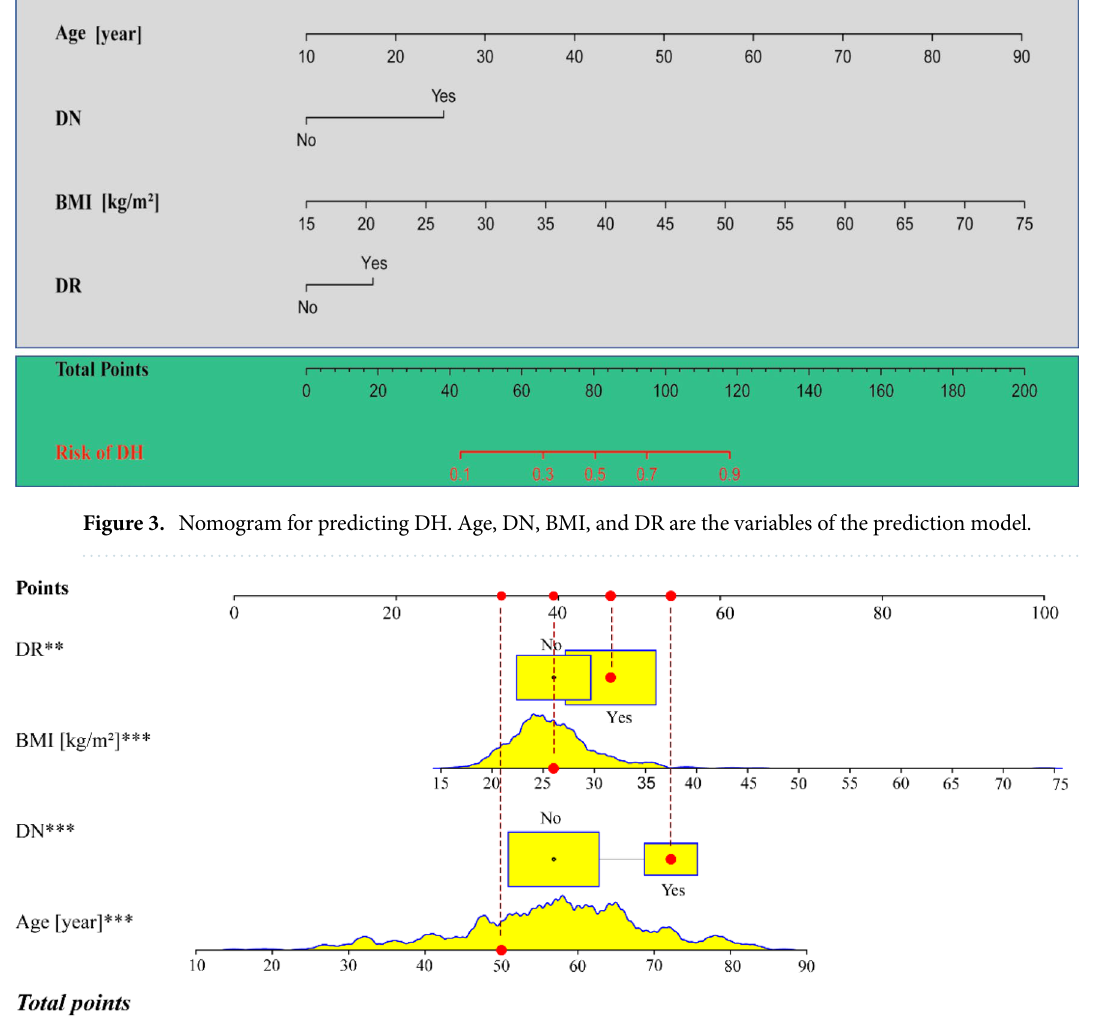
(Fig. 6B) were between 0.7–0.9, which indicates that the pretested models had good discrimination in both the training set and the validation sets. Clinical DCA suggests that the nomogram model is beneficial whether in the